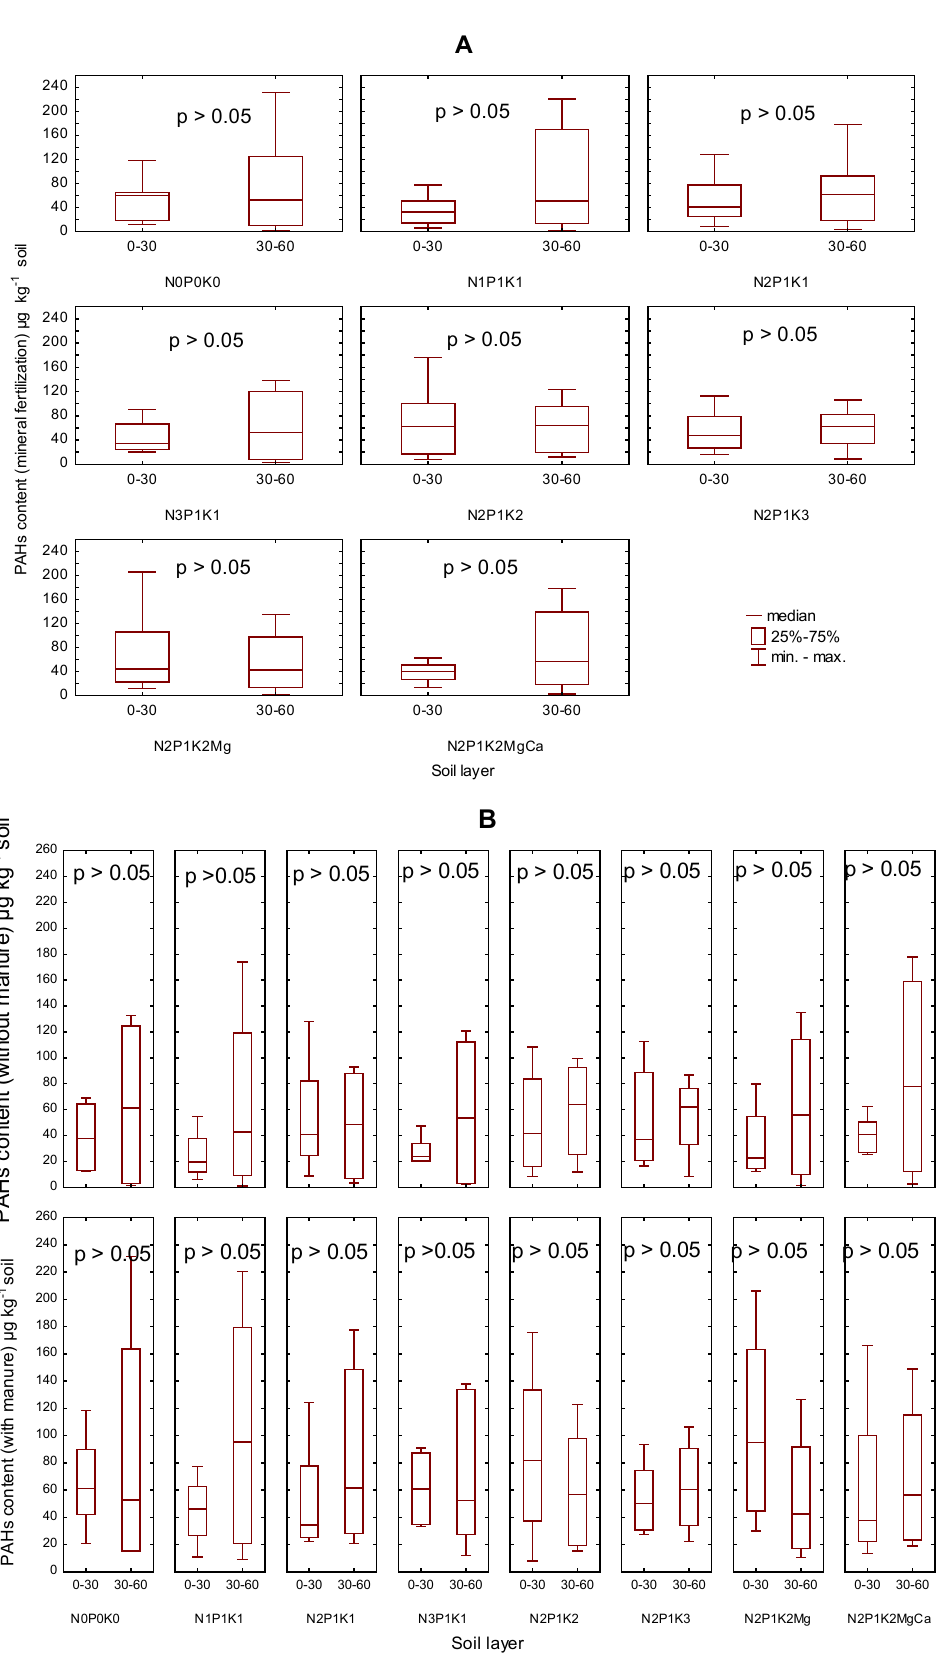
Figure 5. The content of the sum of the light PAHs in soil (0–30 and 30–60 cm) in 2006–2009 depending on mineral fertilization ( A ) and manure-mineral and mineral fertilization ( B ) in µg kg − 1 .